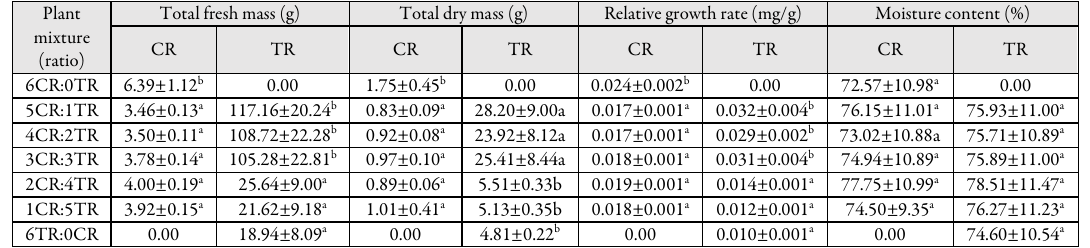
Table 5. Fresh and dry mass, relative growth rate and moisture content of C. odorata and T. rotundifolia grown under interspecific